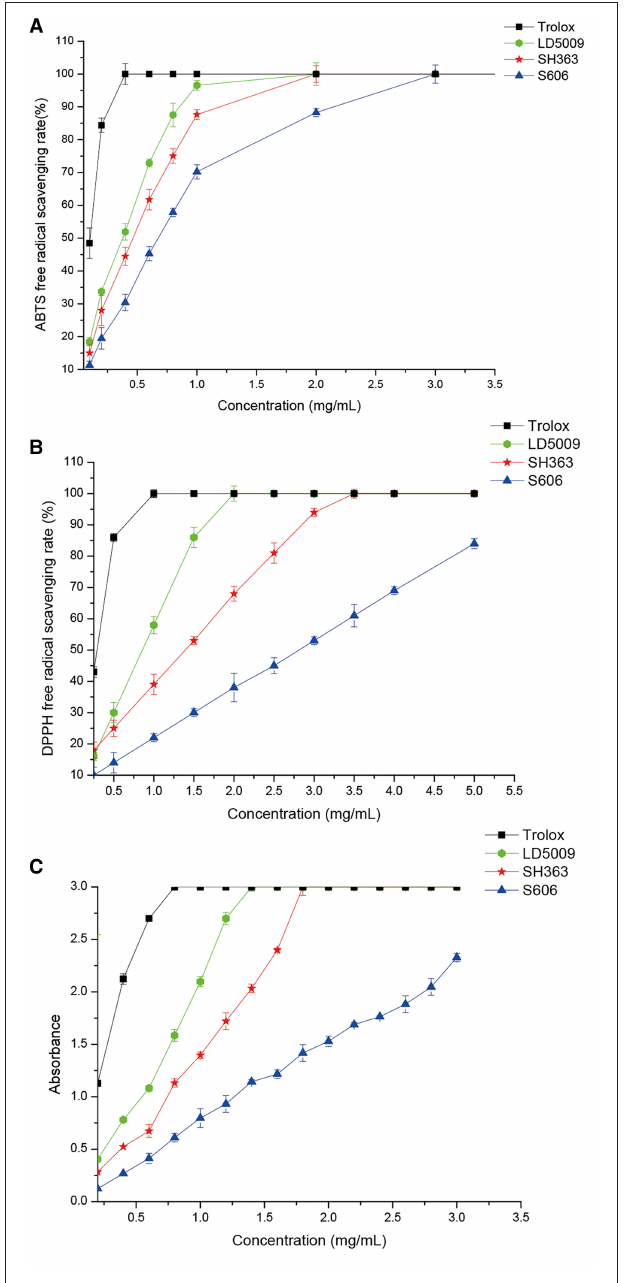
FIGURE 4 | Antioxidant activities of SEOs from the different varieties of sunflowers. (A) ABTS free-radical scavenging rate of SEOs from different varieties of sunflowers. (B) DPPH free radical scavenging rate of SEOs from different varieties of sunflowers. (C) Iron ion reduction ability of SEOs from different varieties of